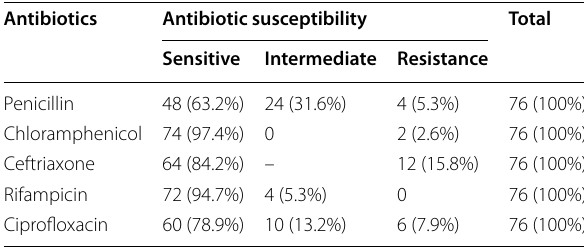
Table 3 Antibiotic susceptibility profile of Neisseria meningitidis isolated from prisoners at correction facility in Jimma Town, Southwestern Ethiopia,